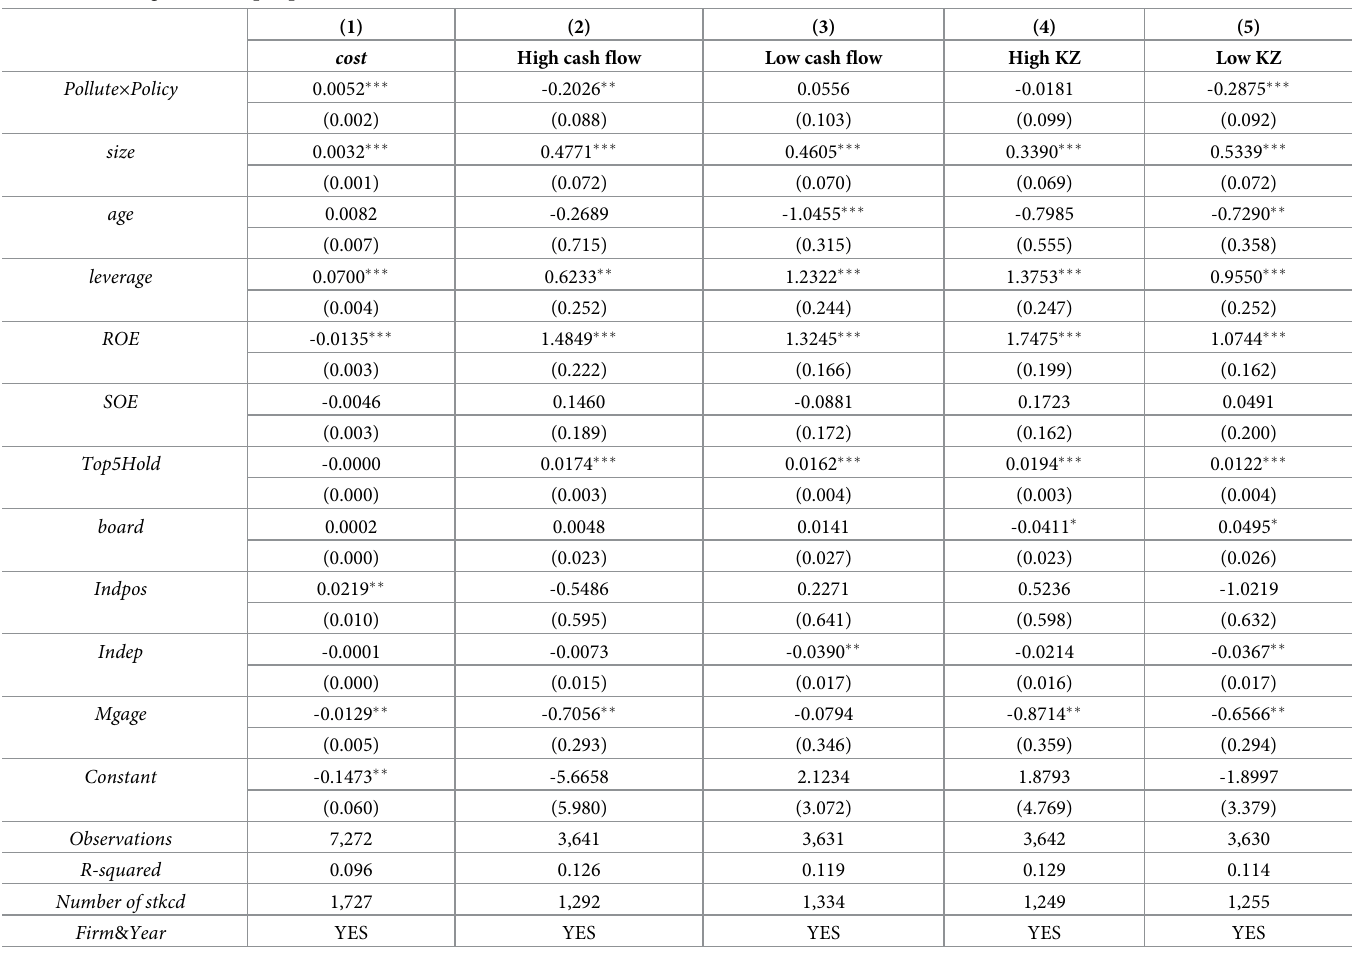
Table 7. Financing constraint